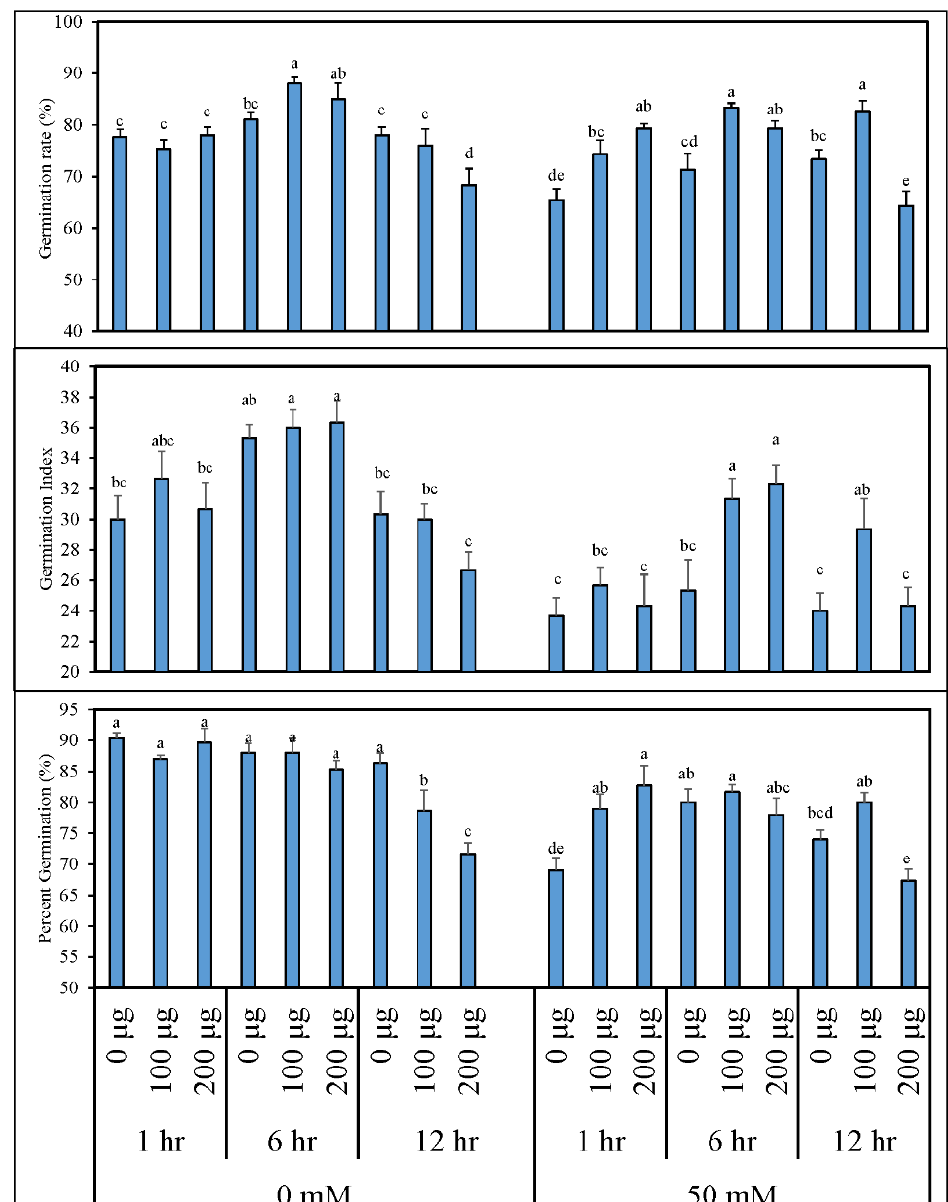
Figure 1. Percentage germination (%), germination rate (%), and germination index of tomato after seed priming with di ff erent concentrations of aqueous garlic extract (AGE). Tomato seeds were primed with 0, 100, and 200 µ g · mL − 1 AGE for 1, 6, and 12 h and germinated under 0 and 50 mM NaCl stress. Obtained data were subjected to analysis of variance (ANOVA) using factorial design. Di ff erences among the means were calculated with Tukey’s honestly significant di ff erence (HSD) ( p = 0.05). Means followed by the same letters bear no significant difference.